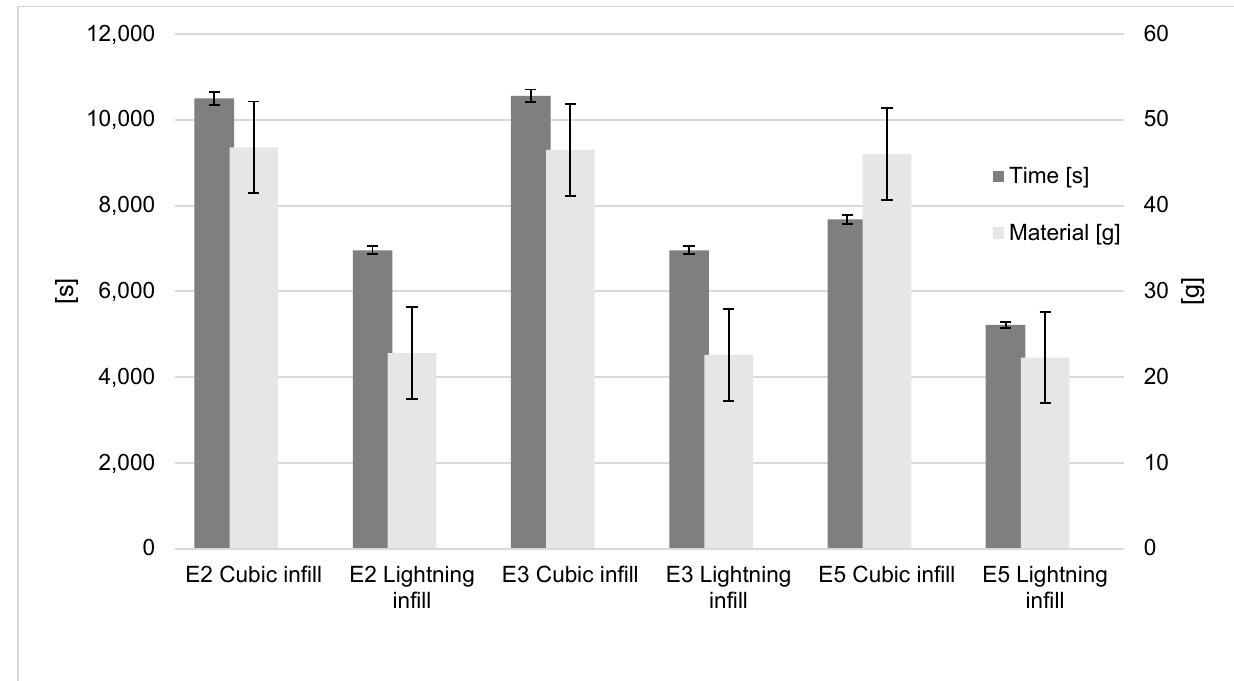
Figure 9. Infill influence on energy results.